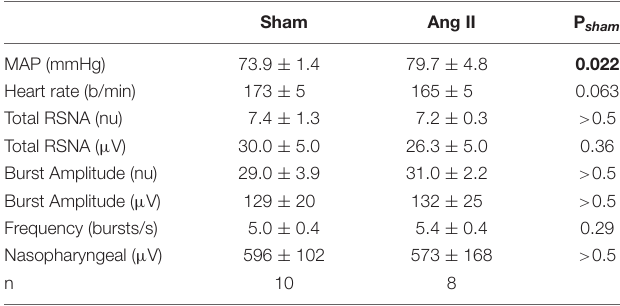
TABLE 1 | Cardiovascular parameters and renal sympathetic nerve activity (RSNA) after 12 weeks Ang II or sham treatment. Sham Ang II P